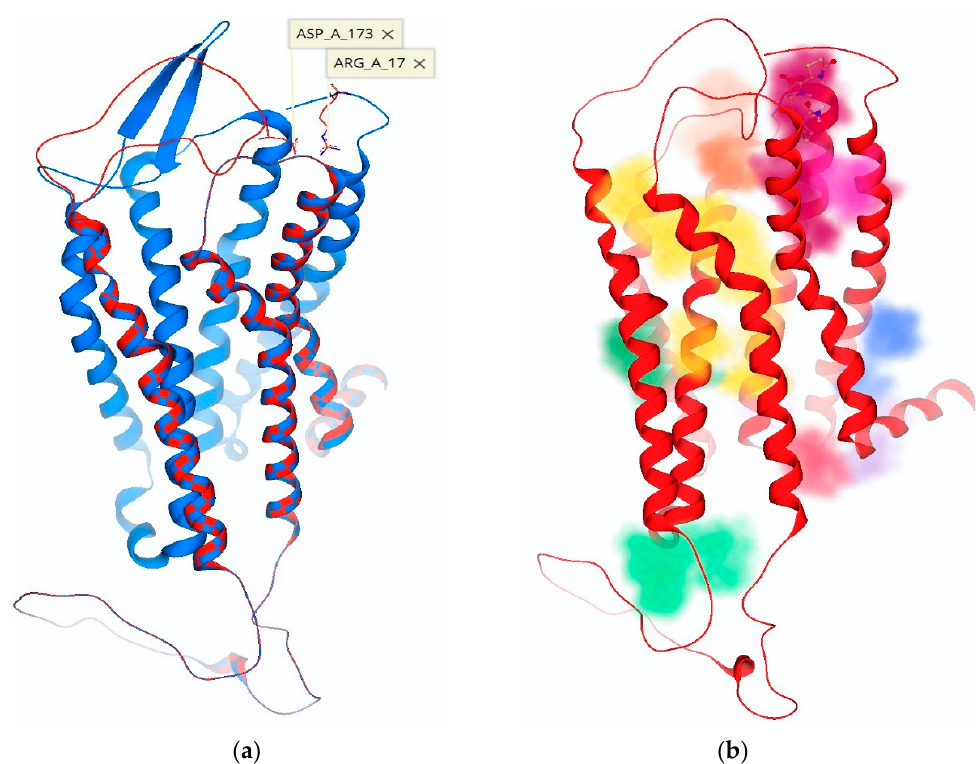
Figure 6. ( a ) The three-dimensional structure of the TRH receptor with an overlay of ECL-2 in the “open” (blue) versus the “closed” (red) position, following ECL-2 remodeling. ( b ) Pocket detection software highlights possible binding sites with various colors: the antagonist 1b (Figure 1) is shown docked in its allosteric binding site (magenta), and the TMB channel leading to the active binding site is highlighted in yellow.